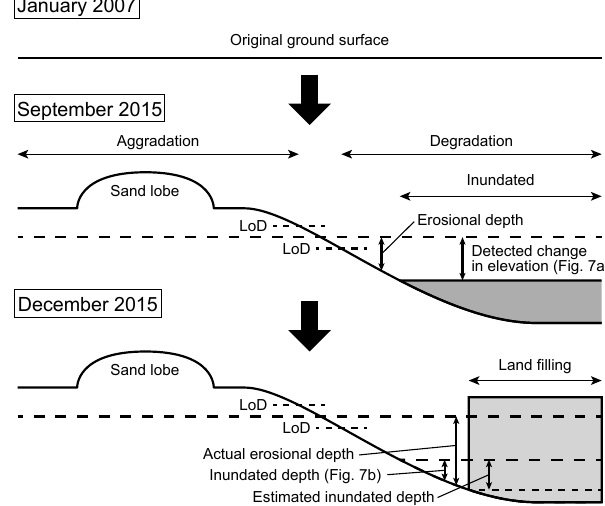
Figure 8. Schematic description of the topographic changes caused by the flood and the later disappearance of inundation water and land filling. Note that elevation changes smaller than the LoD were neglected in the differential rasters and the volume